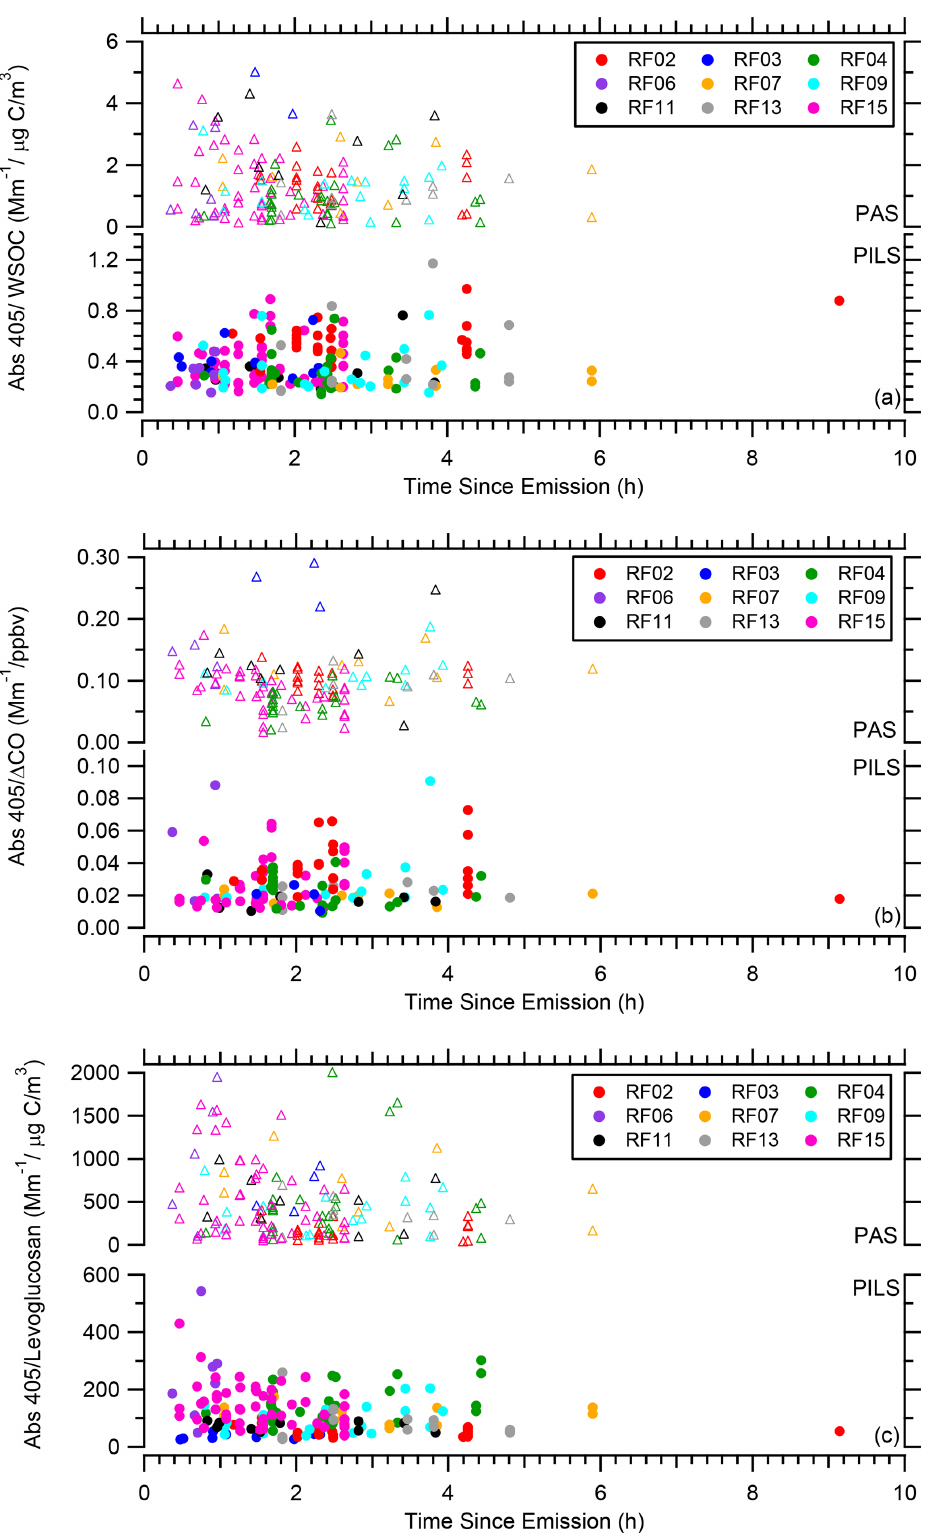
Figure 10. (a) Abs 405 / WSOC, (b) Abs 405 /(cid:49) CO, and (c) Abs 405 / levoglucosan as a function of time since emission for all WE-CAN flights with the data segregated by flight. In each plot the PAS total Abs 405 BrC is on top and the PILS water-soluble Abs 405 on the bottom.